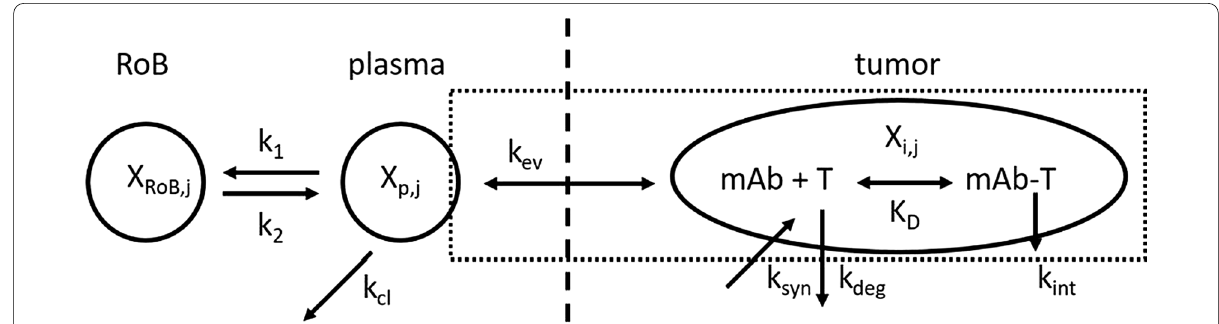
Fig. 2 Schematic structure of the mathematical model. The area within the dotted line contains the contributions to the measured PET signal. The dashed line indicates the border between vascular and interstitial space. On the left hand side of the dashed line a two‑compartment plasma PK model characterizes systemic PK. The subscript j can be either l (labeled) referring to 89 Zr‑mAb or u (unlabeled) referring to